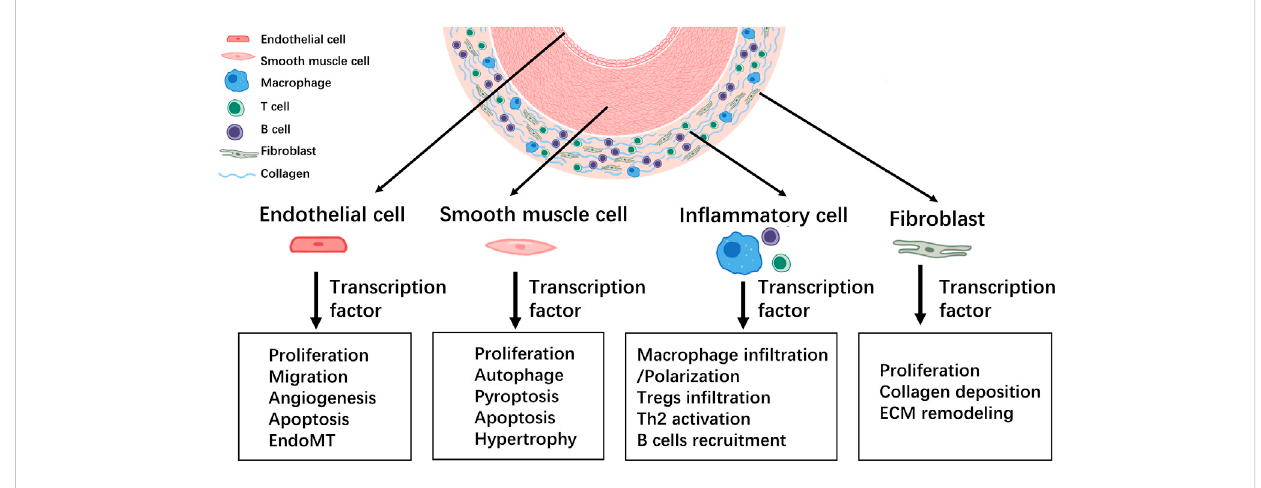
FIGURE 3 Summary of the involvement of transcription factors in the development of pulmonary vascular remodeling during